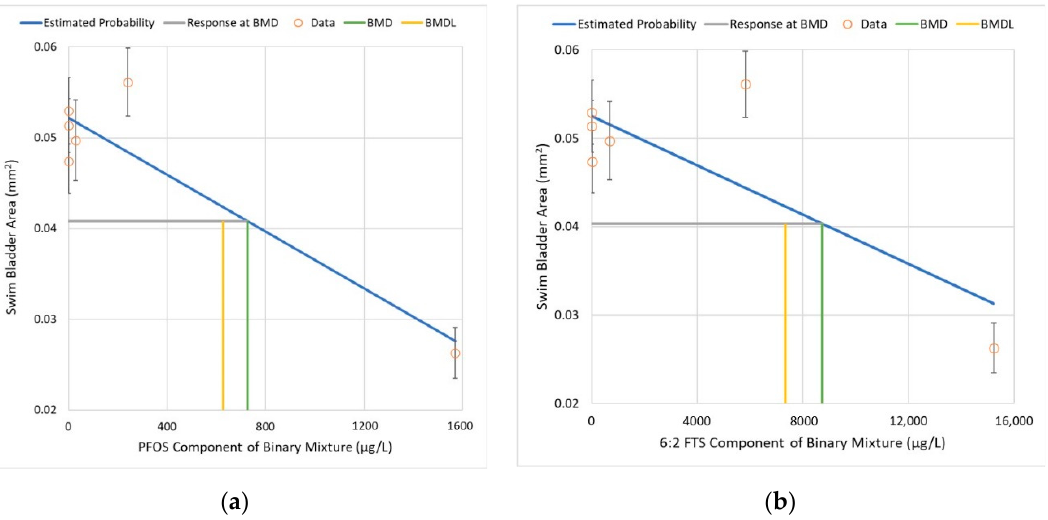
Figure 6. Dose–response curves for the binary mixtures experiment, showing each component chemical with SBA (all three replicates combined): ( a ) Linear D–R model fit for PFOS. ( b ) Linear D–R model fit for 6:2 FTS. See Table 6 for model parameters and relative contributions of each chemical to the total dose across a range of response levels.